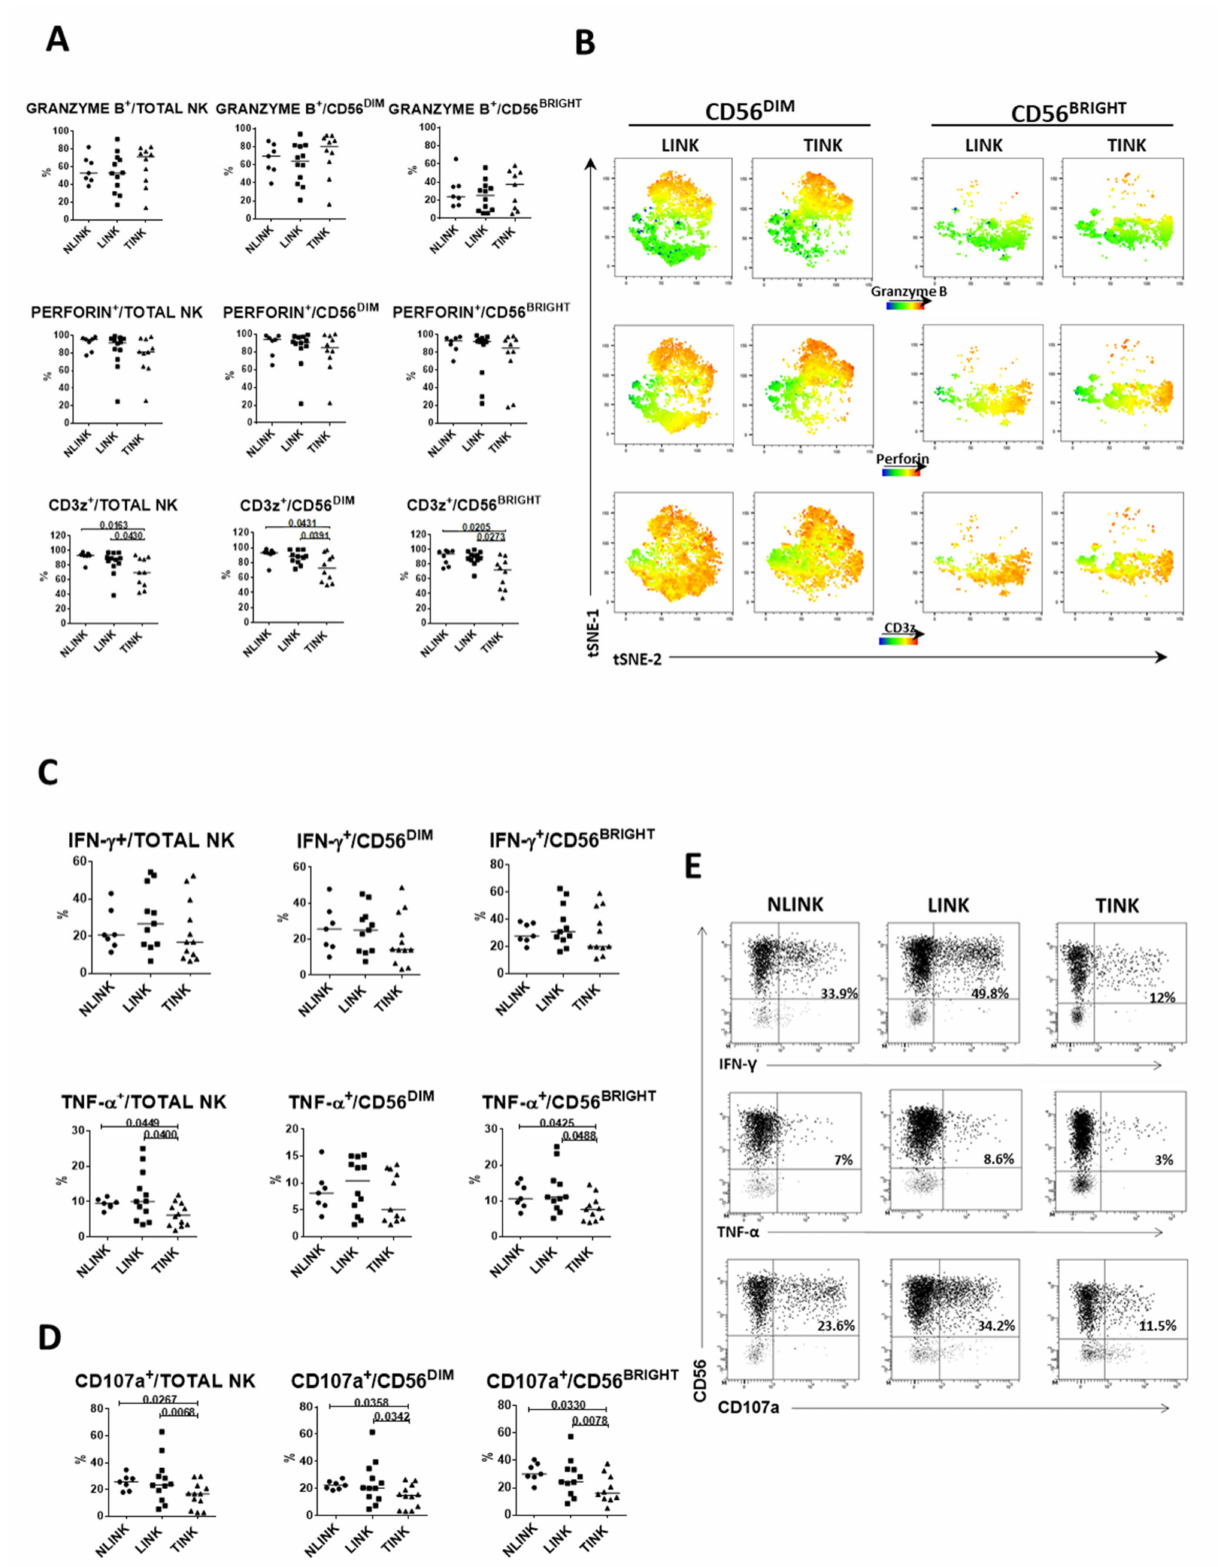
Figure 4. Infiltrating NK cell functional analyses. ( A ). Percentage of granzyme B+ (upper panels), perforin+ (middle panels), and CD3 ζ + (lower panels) cells in NK cell subsets from NLINK (n. 7), LINK (n. 12), and TINK (n. 12). ( B ). The dimensionality reduction algorithm tSNE was applied to flow cytometry data (single-cell expression values from total live lymphocytes for CD3, CD56, perforin, granzyme B, and CD3z) to generate a two-dimensional map of NK cells from